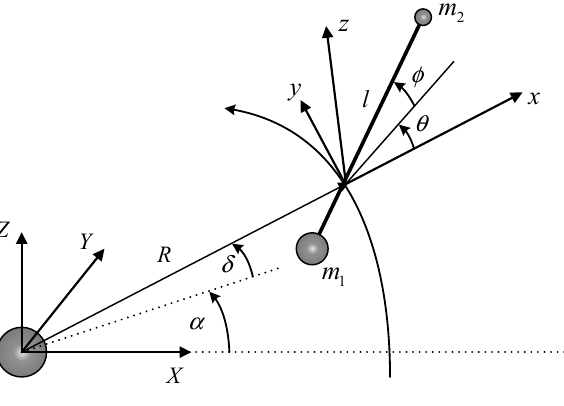
Figure 1. Rigid tether dynamical model.